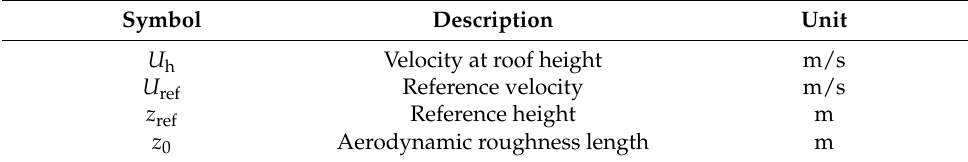
Table 1. Cont. Symbol Description